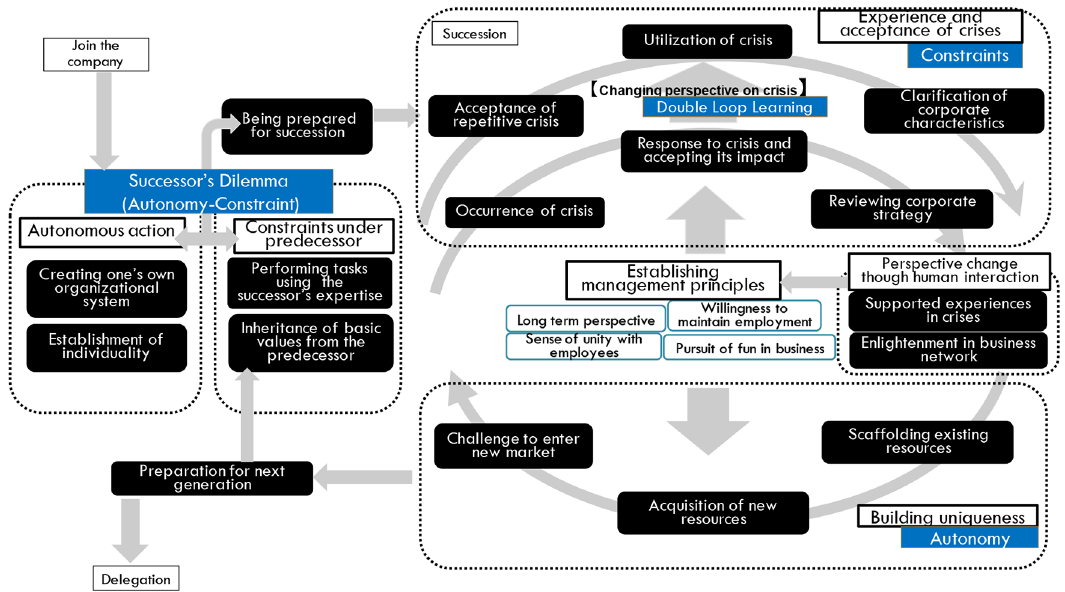
Figure 3. Interpretation of the analysis result